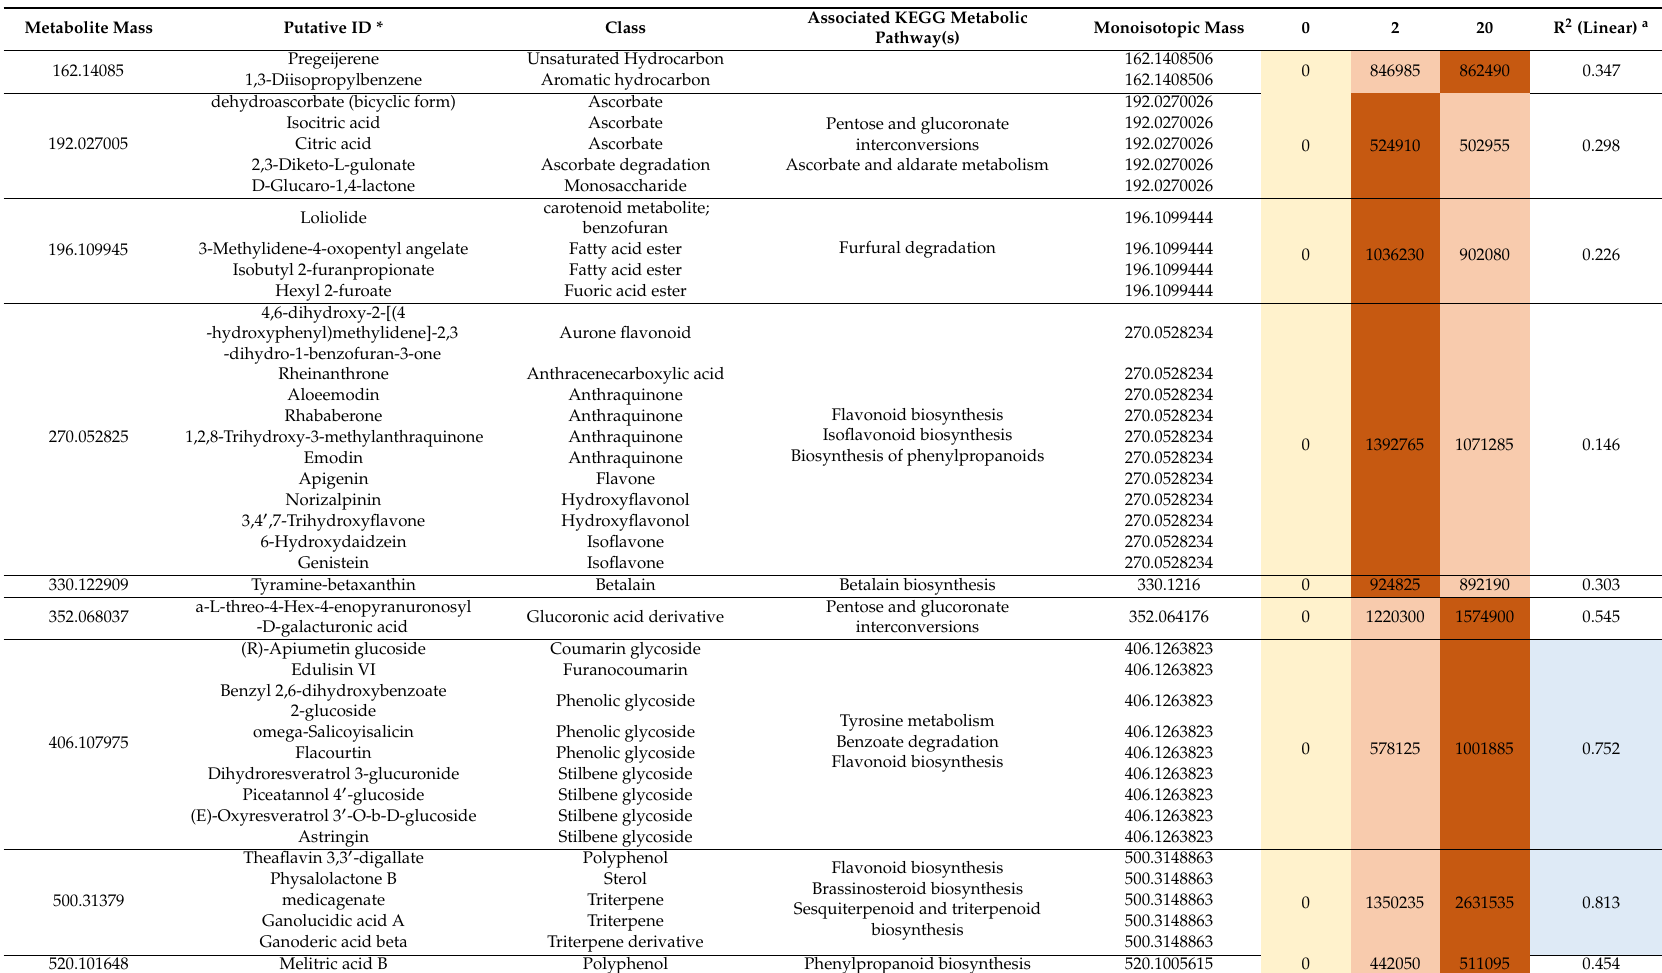
Table 2. Metabolites that were not detected in controls but present in thidiazuron (2 or 20 µ M) treated tissues. Metabolite mass is the predicted monoisotopic mass of the compound, monoisotopic mass is the known monoisotopic mass (as predicted by ChemSpider). Data is presented as mean ion intensity. Regression coe ffi cient (R 2 ) was determined for the linear relationship of 20 µ M > 2 µ M > 0. Shading darkens with increasing